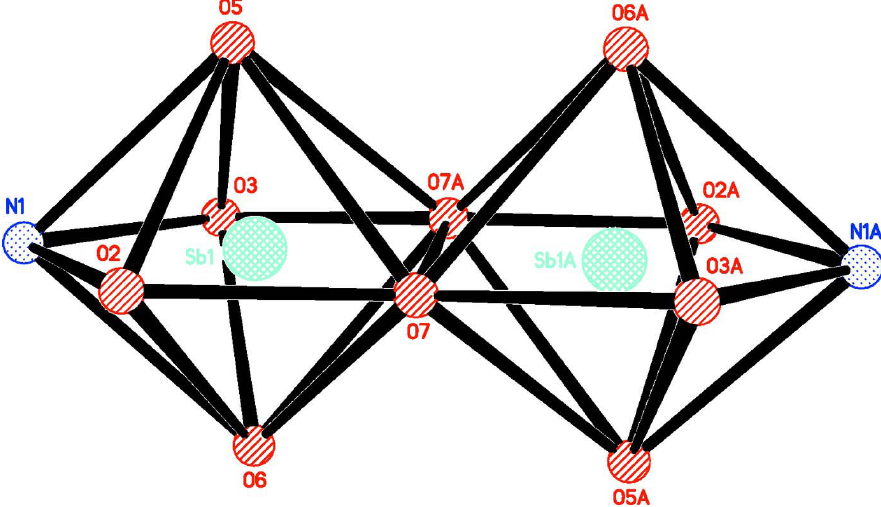
Figure 3 The coordination environment of the Sb III /Sb V centers. Atoms marked with A are related by the symmetry code (- x , - y , - z